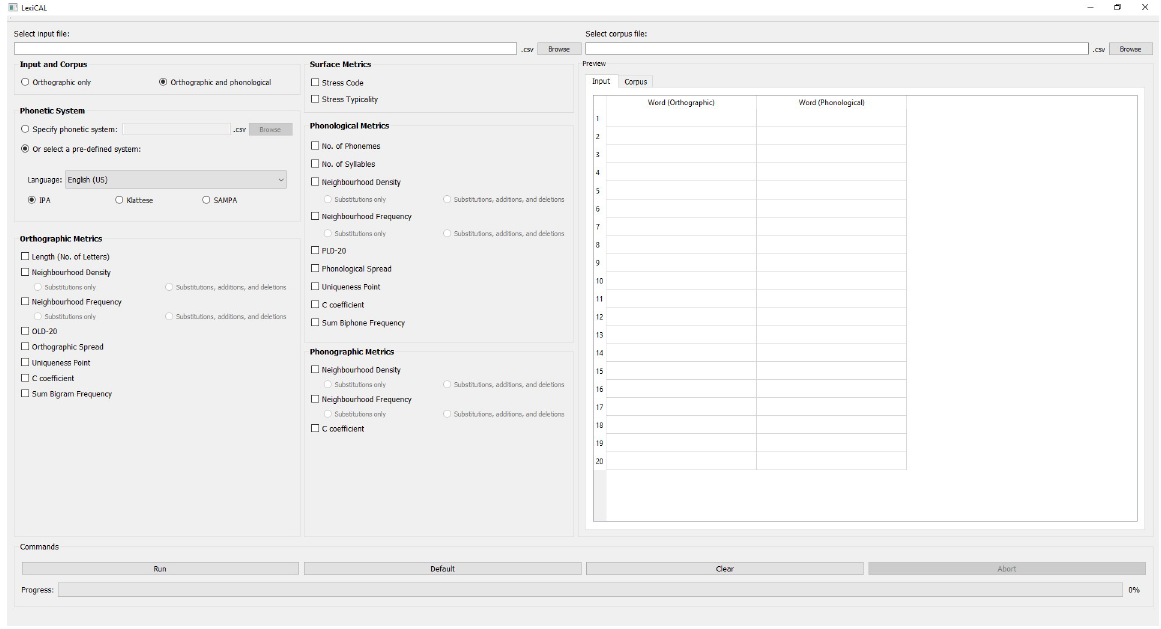
Fig 1. Main window of the